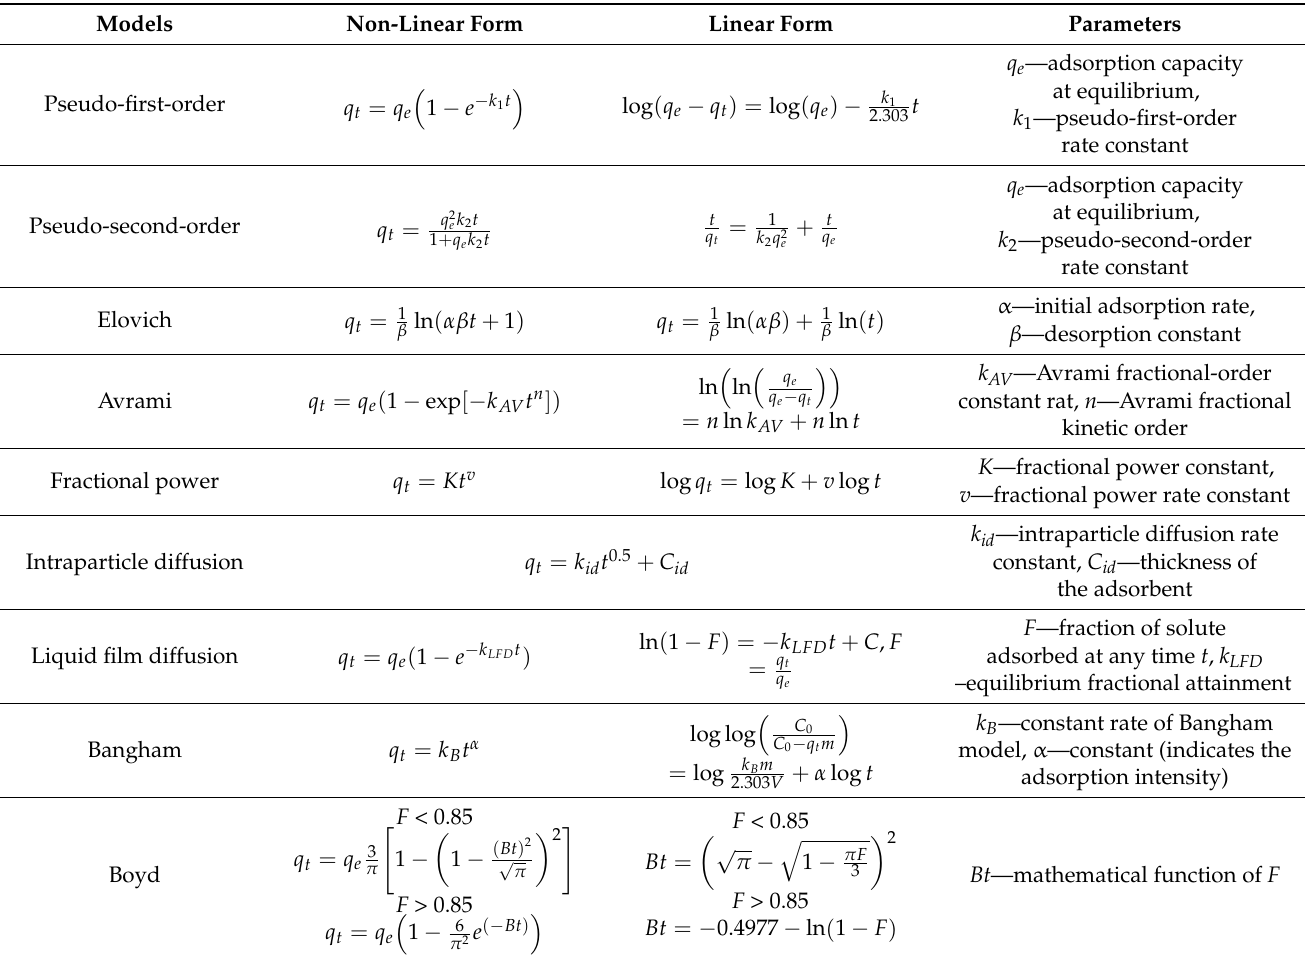
Table 2. Kinetics and mechanism of adsorption (nonlinear and linear form with the description of parameters)